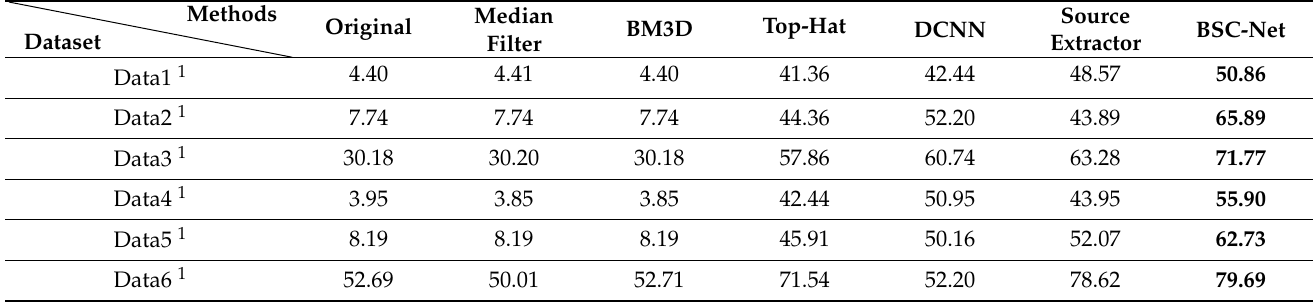
Table 1. The quantitative results on different datasets based on